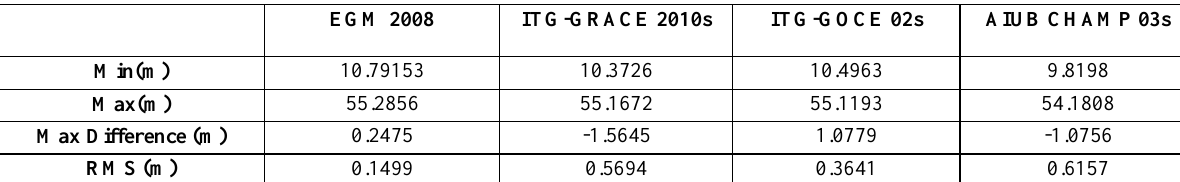
Table 2. Statistic of geoid heights from GGMs compared to airborne gravity